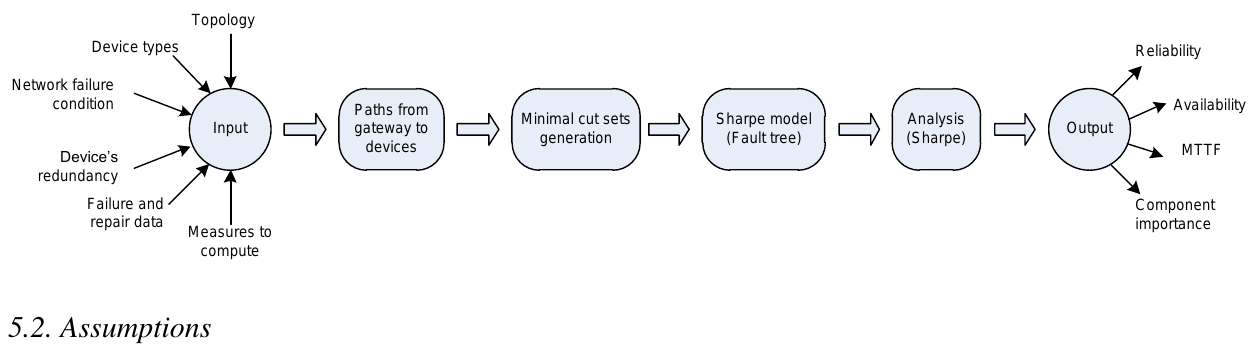
Figure 4. Overview of the methodology for reliability and availability